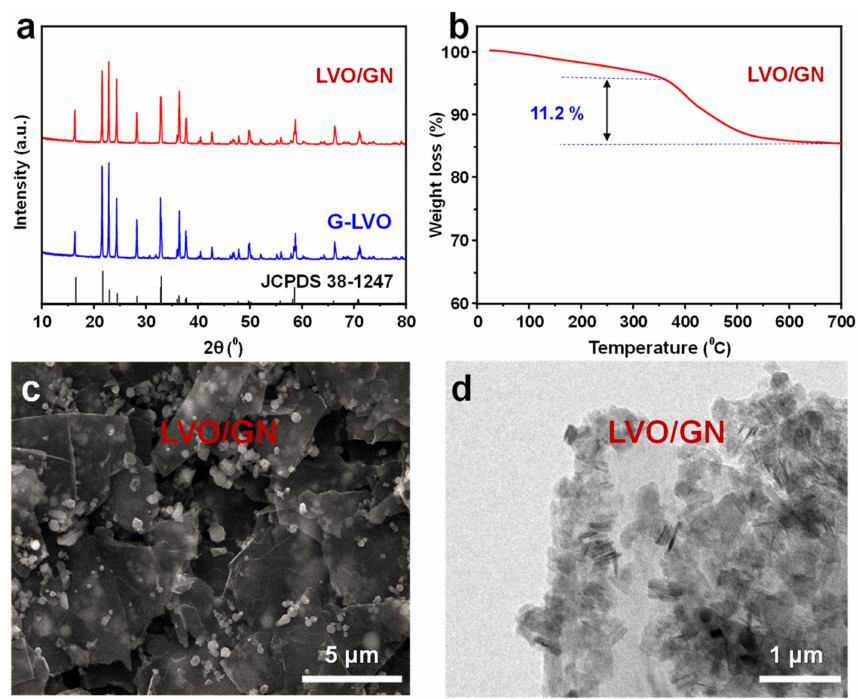
Figure 3. ( a ) XRD patterns of LVO and LVO/GN composite. ( b ) TGA curve of LVO/GN composite.